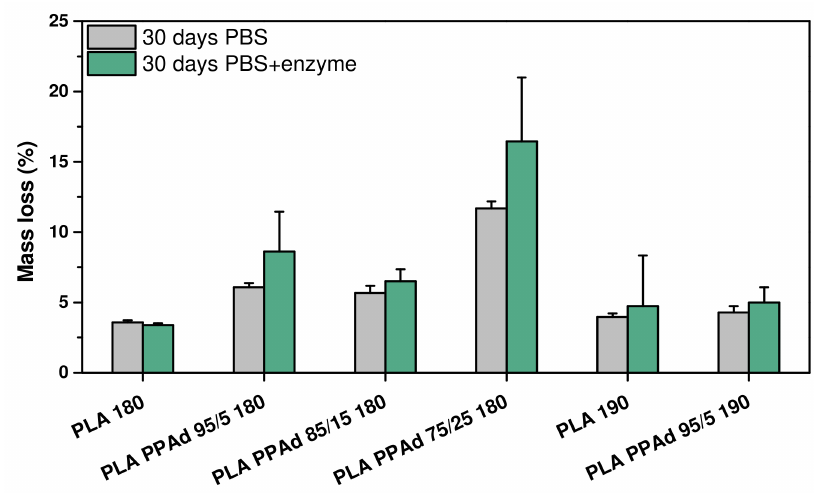
Figure 11. Effect of the presence of enzymes in the hydrolysis of the samples for 30 days.